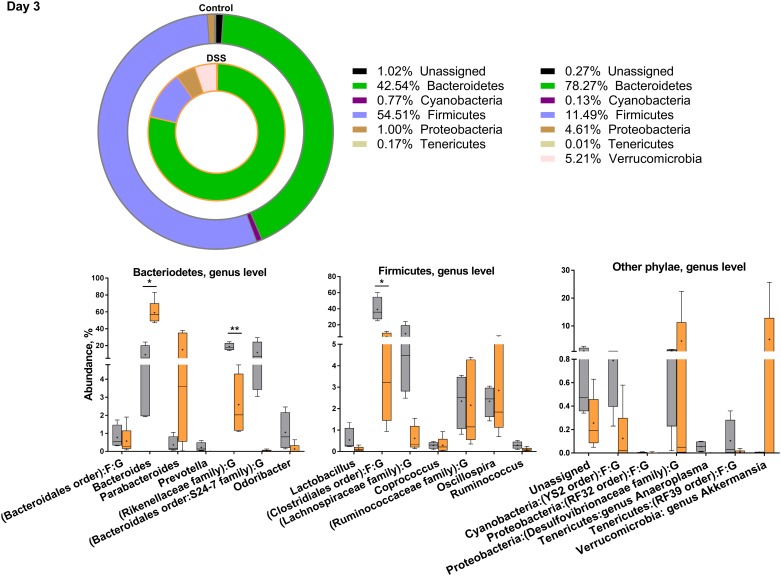
Distribution of the 20 most abundant phyla on day 3 of treatment.Overview of relative phylogenetic distribution and details of variation down to genus level of gut microbiota of untreated control mice and mice during treatment with 1.5% dextran sulfate sodium (DSS). There were too few reads from DSS+Ampicillin and DSS+Ampicillin+LPS treated mice on day 3 and day 1 post-treatment. Verrucomicrobia amount on day 3 and day 1 post-treatment is for one mouse only. See S2 Table for analysis of variance.